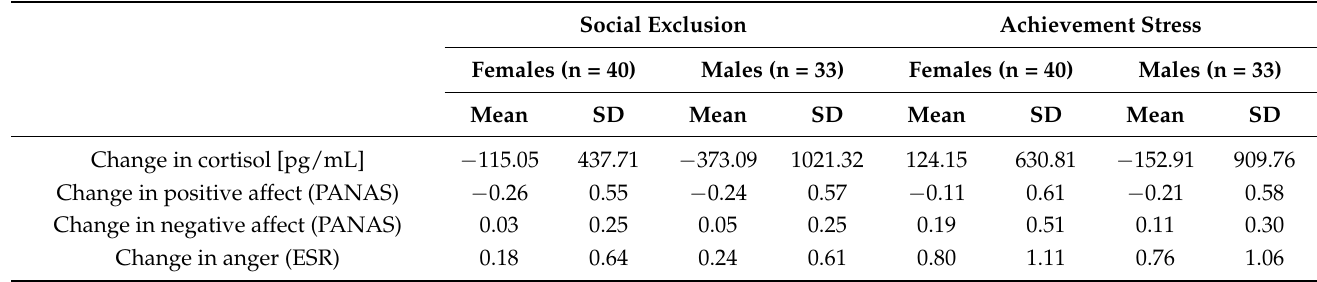
Table 3. Changes in cortisol and subjective ratings due to social exclusion and achievement